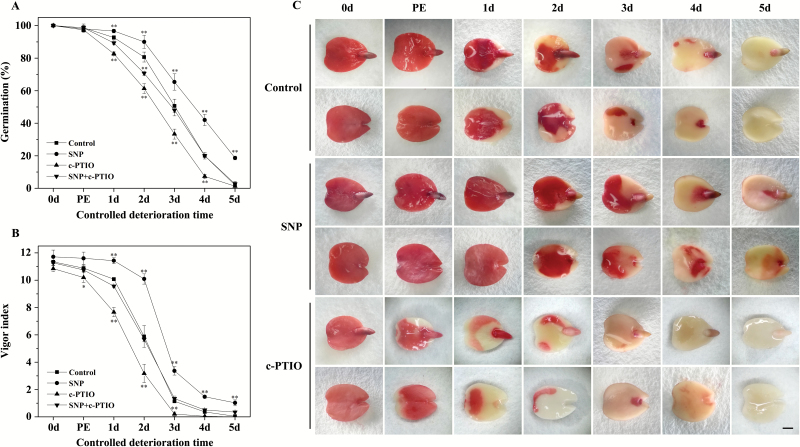
Effect of NO on seed vigour during controlled deterioration treatment (CDT). (A, B) Effects of SNP and c-PTIO on the germination percentage (A) and the vigour index (B) of ageing seeds. Seeds were treated with either 100 μM SNP vapour or 50 μM c-PTIO, or imbibed with c-PTIO and then treated with SNP vapour, and the percentage of germination was calculated after 7 d of imbibition. Data are presented as the mean ±SD of three replicates. PE, post-equilibration. *P<0.05; **P<0.01. (C) Effect of SNP (100 μM) or c-PTIO (50 μM) on the TTC staining of seeds during CDT. Light micrographs showed the two pieces of elm cotyledon after the TTC staining. PE, post-equilibration. Scale bars=1 mm.